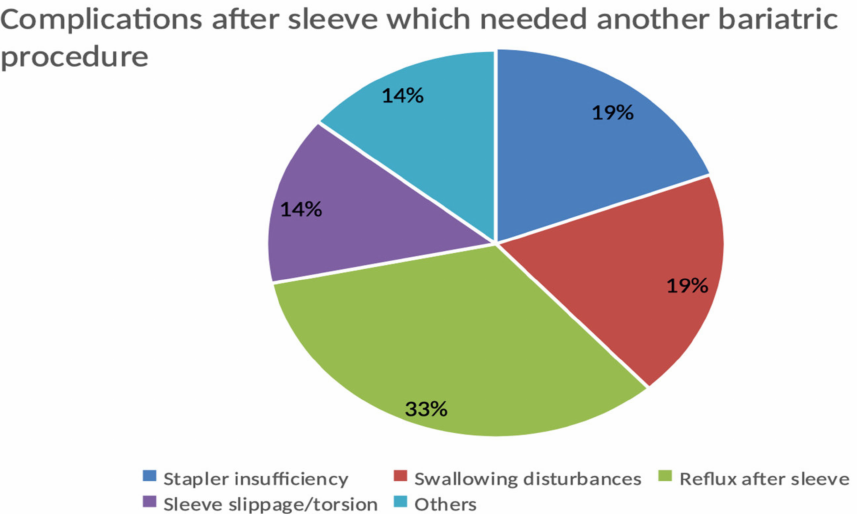
Figure 3. Complications after sleeve driving towards revisional operation in the whole